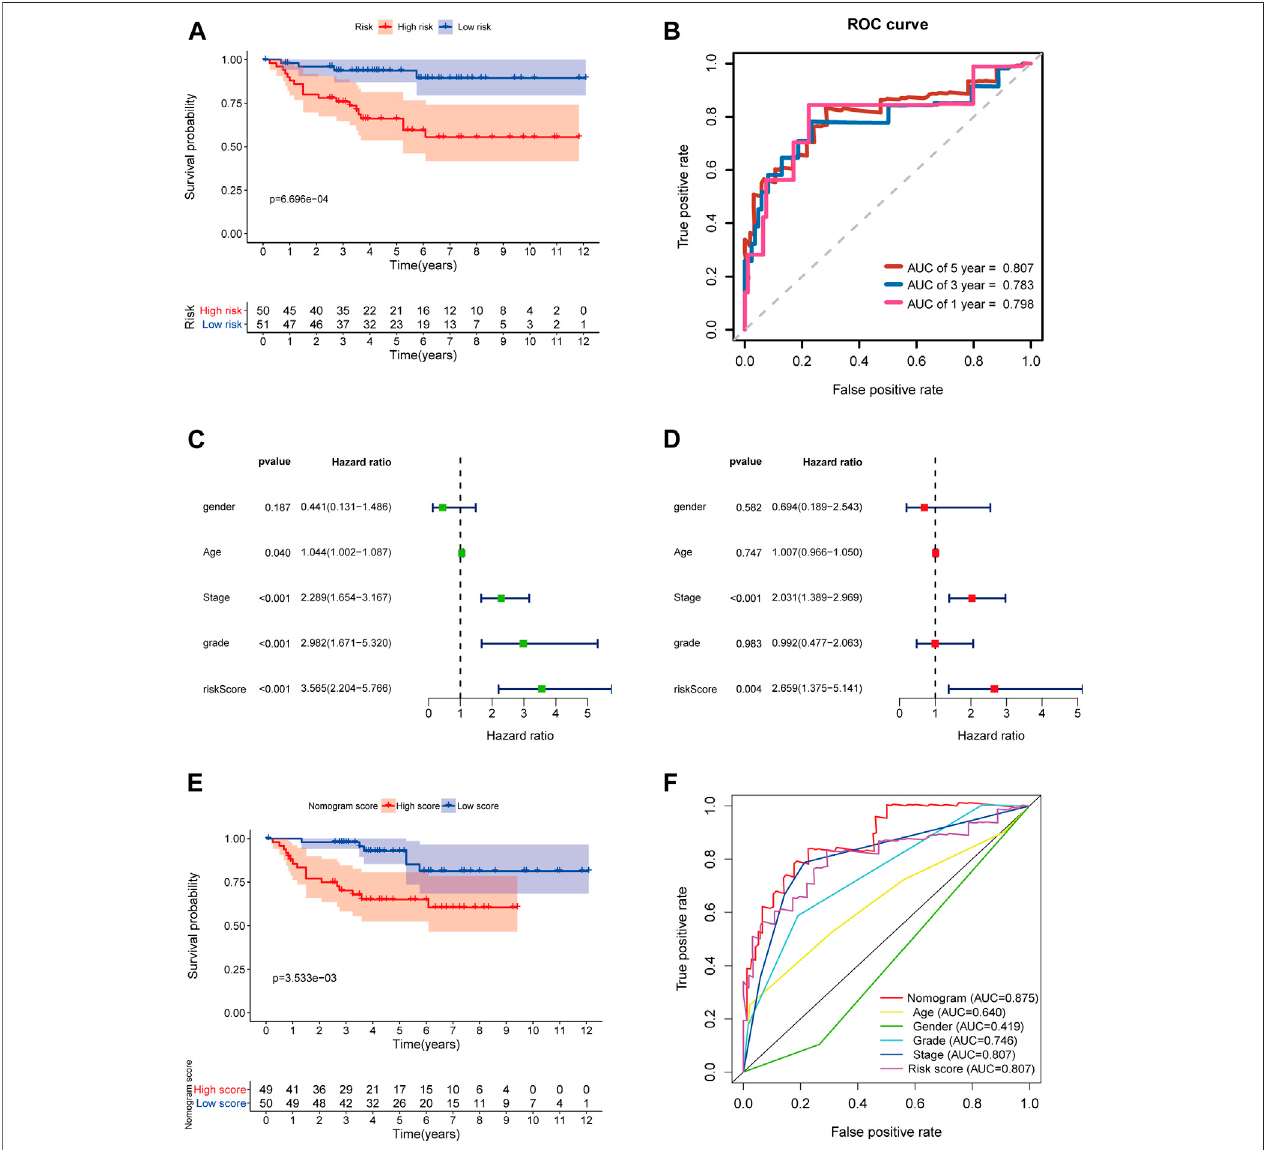
FIGURE 12 | External validation of the prognostic 5-gene signature and nomogram in the E-MTAB-1980 dataset. (A) Kaplan – Meier survival analysis based on the 5-gene signature in the E-MTAB-1980 dataset; (B) Time-dependent ROC curves of the 5-gene signature for 1-, 3-, and 5-year OS in the E-MTAB-1980 dataset; (C – D) UnivariateandmultivariateCoxregressionanalyses; (E) Kaplan – MeiersurvivalanalysisbasedonthenomogramintheE-MTAB-1980dataset; (F) Time-dependentROC curves of the nomogram, age, gender, stage, grade, and risk score.